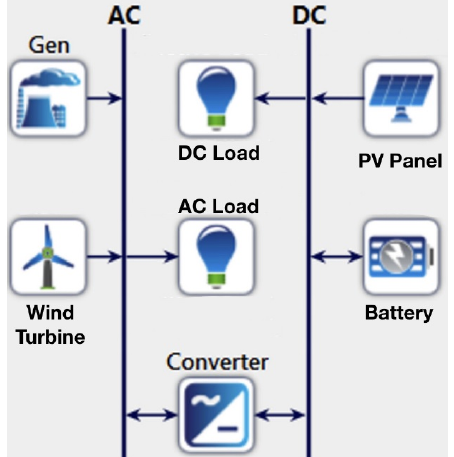
Figure 4. Simulated system model in